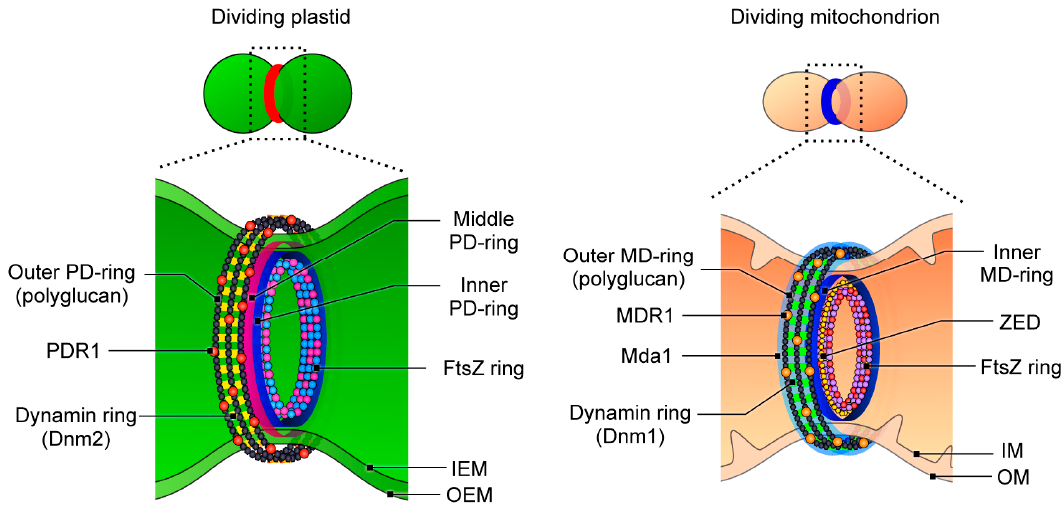
Figure 5. Schematic representations of the division machinery in plastids and mitochondria. IEM, inner envelope membrane; OEM, outer envelope membrane; IM, inner membrane; OM, outer membrane. For details on the mitochondrial-division machinery, see Refs. [1,54–58]. Modified from Yoshida et al. (2016) [21] and Yoshida et al. (2017) [54].